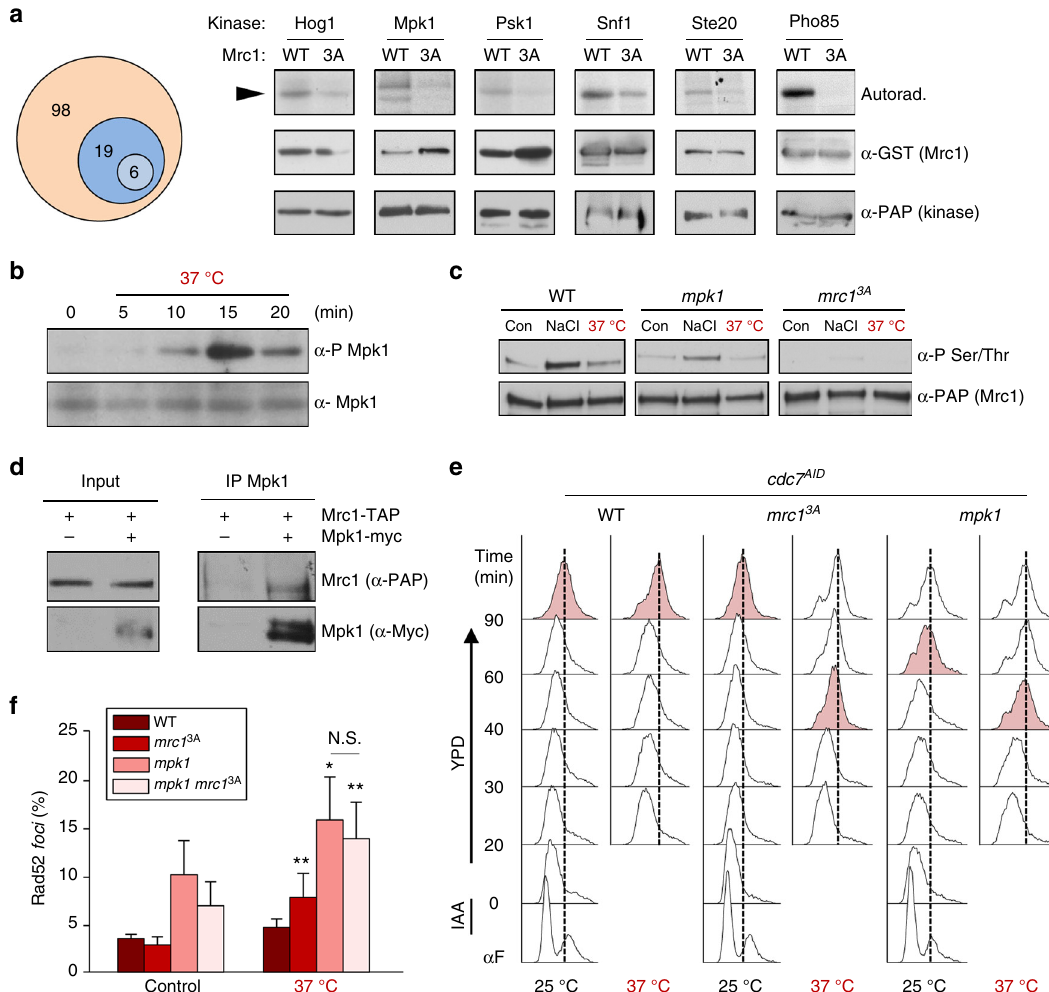
Fig. 4 A kinase screen identi fi ed several kinases that phosphorylate the N terminus of Mrc1. a Six kinases phosphorylate the N terminus of Mrc1. In the screen, 123 tagged-puri fi ed yeast kinases were incubated in an in vitro kinase assay with a fragment (1 – 360 aa) of Mrc1 or its corresponding mutant in which the three phosphorylation sites Thr169, Ser215, and Ser229 were mutated to alanine ( mrc1 3A ) (see “ Methods ” section). Out of these 123 in vivo- puri fi ed kinases, 25 kinases (in blue) phosphorylated GST – Mrc1 in an in vitro kinase assay. Six of these 25 kinases phosphorylated GST – Mrc1 but not GST- mrc1 3A . b – f Mpk1 kinase mediates the Mrc1-dependent cell cycle delay upon heat stress. b Mpk1 is phosphorylated in vivo upon heat stress. Synchronized cells were released into S phase and subjected to heat stress. Mpk1 phosphorylation over time was followed by western blotting using speci fi c antibodies. Nonphosphorylated Mpk1 was blotted as a loading control ( c ) Mrc1 is phosphorylated in vivo by Mpk1 upon heat stress. This experiment was carried out as in Fig. 1a and was assayed as in b . d Mrc1 and Mpk1 interact in vivo. Mrc1 – TAP was immunoprecipitated (IP) from cells and coprecipitated Mpk1-myc was assayed using western blotting. e mpk1 cells bypass the DNA replication delay caused by heat stress. Pheromone presynchronized cells were arrested at S- phase onset using the cdc7 AID (auxin-induced degron) system before their release at 37 °C (heat stress). DNA replication over time was followed using FACS. f mpk1 cells display a higher percentage of Rad52-YFP foci upon heat stress. Data represent the mean and standard deviation of three independent experiments. Asterisks indicate statistically signi fi cant differences by Student's t test (* p < 0.05, ** p < 0.01, *** p < 0.005) of stress versus